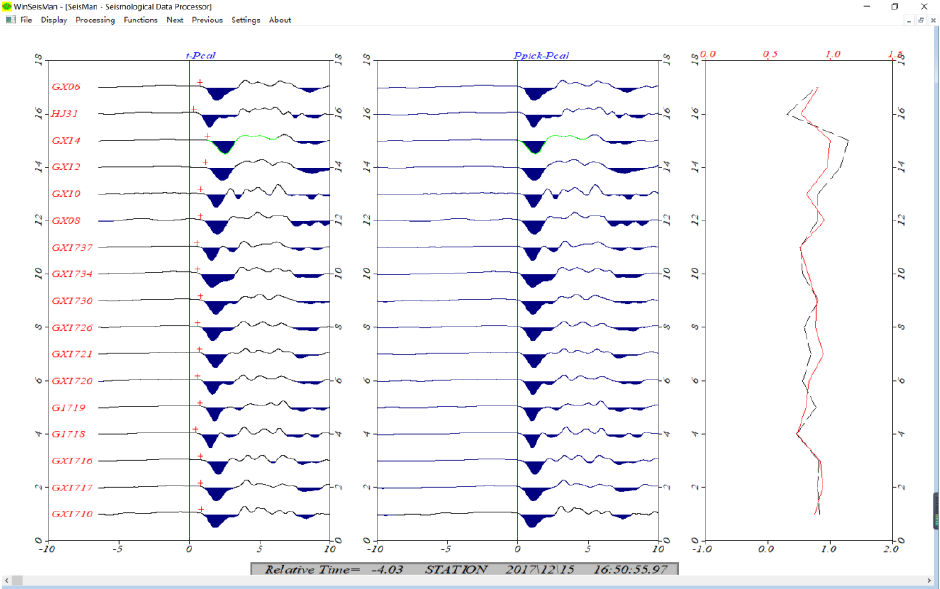
Figure 12. Cross-correlation evaluation system. The left and middle panels show the seismic waveforms centered on the theoretical and measured traveltimes. The red line on the rightmost graph is the correlation coefficient, and the corresponding numbers are the upper red axis. The black line shows the residual difference between the measured traveltime and the theoretical traveltime; the corresponding numbers are the lower black coordinates in